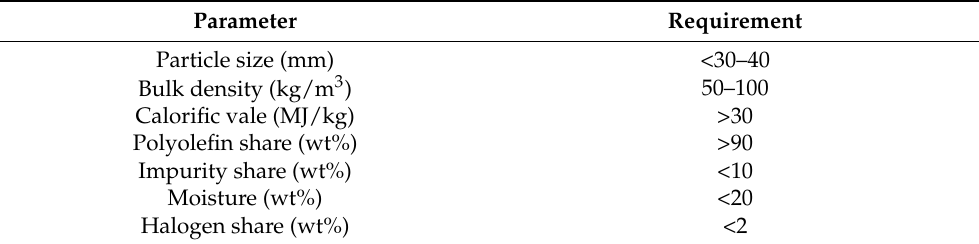
Table 5. Feedstock requirements for thermo-chemical conversion